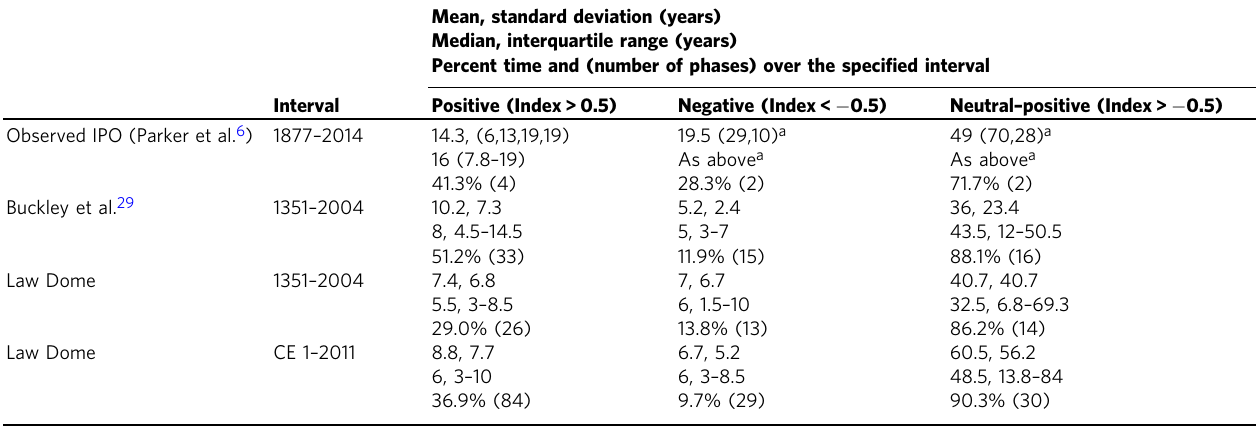
Table 1 Phase length and frequency statistics for IPO observations and reconstructions over the stated